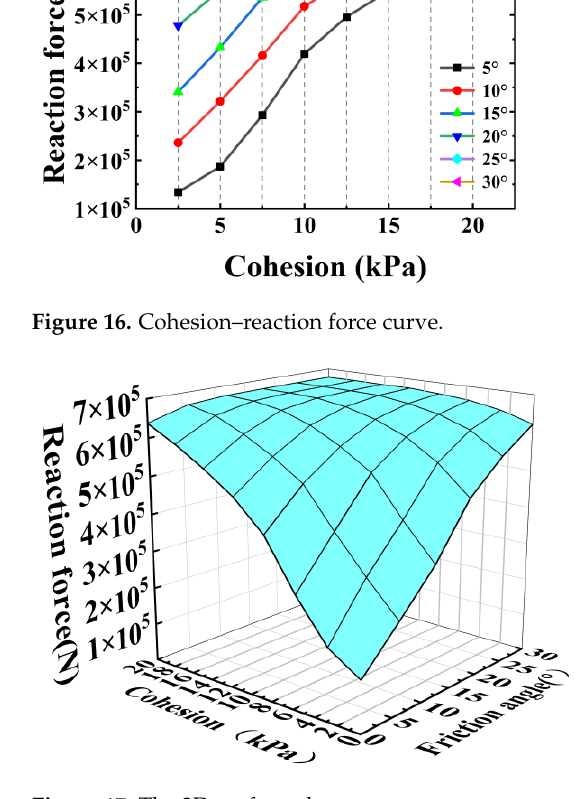
Figure 17. The 3D surface